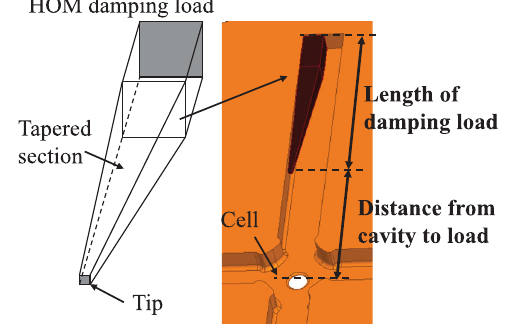
FIG. 19. Geometry of a HOMs damping load.